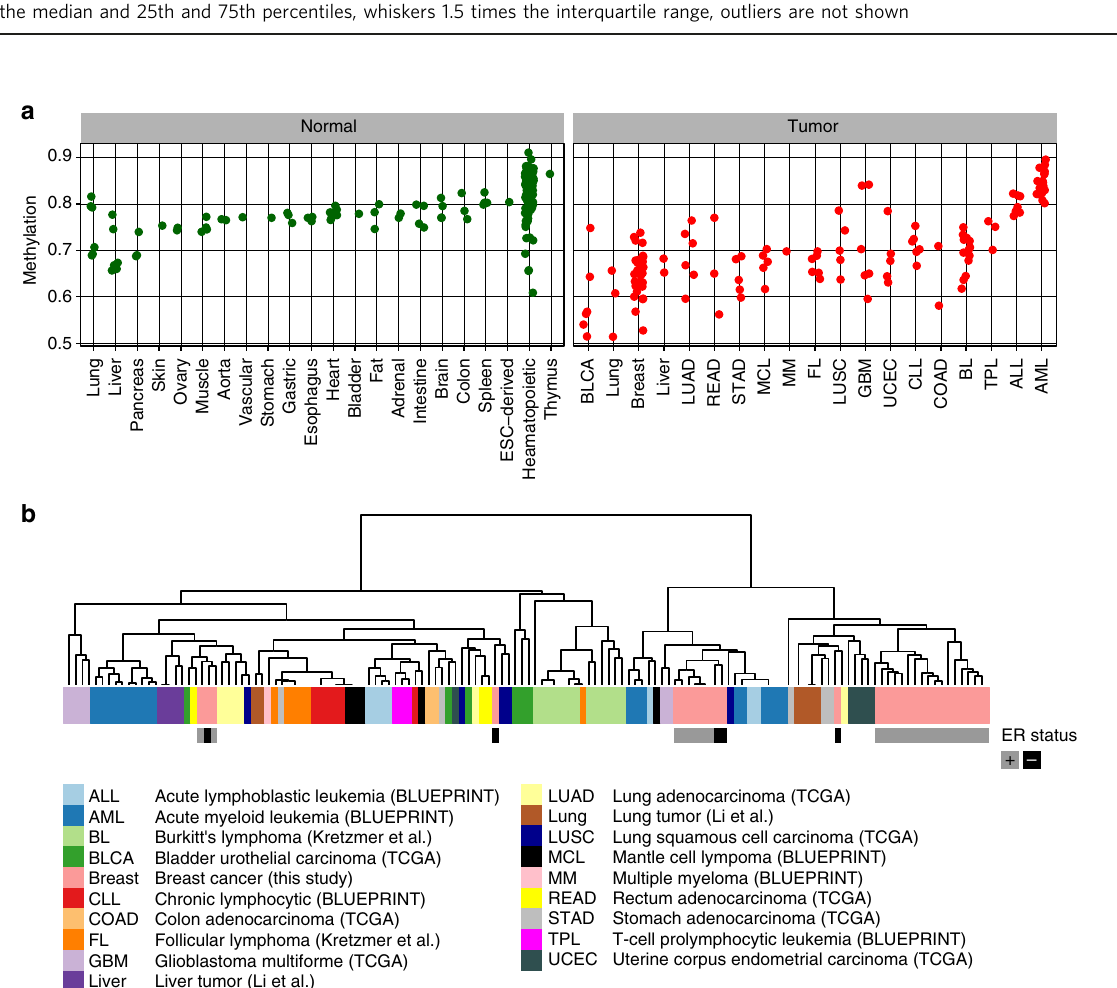
Fig. 3 CpG island hypermethylation inside PMDs. a Representative 2.1-Mb genomic region. Red bars, PMDs for each tumor; below, CGI methylation per tumor (same ordering). Green bars, CGIs. b CGI methylation as the fraction of all CGIs (x-axis). Horizontal bars represent individual tumors. c Methylation over CGIs inside/outside PMDs, averaged over all 30 tumors. Black/red lines, median; gray/pink area, 1st and 3rd quartiles. d CGI counts inside and outside of breast cancer PMDs. “ in ” , CGIs inside PMDs in at least one tumor sample. e Variation of CGI methylation (standard deviation) as a function of PMD frequency. f Regression analysis of B-CIMP ( y -axis) as a function of the fraction CGIs inside PMDs ( x -axis). B-CIMP: the genome-wide fraction of